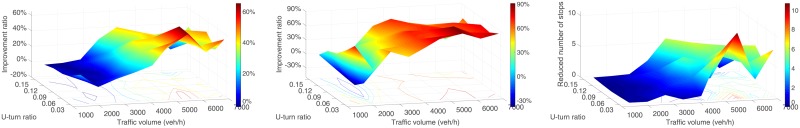
Sensitivity analysis of flow 4, WW U-turn vehicles.The X axis is different traffic volumes, the Y axis is u-turn ratio and the Z axis is improvement ratio (Ratio = (MUTI-ESUL)/MUTI*100%) in a,b, and reduced times (Reduced times = MUTI-ESUL) in c. a. Travel time improvement ratio. b. Delay improvement ratio. c. Reduced number of stops.